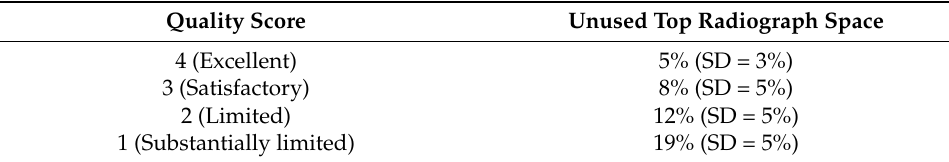
Table 2. Average radiograph “top unused space percentages” corresponding to quality scores assigned by radiologists.